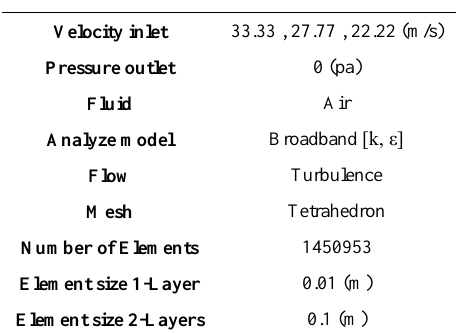
Table 1. Simulation